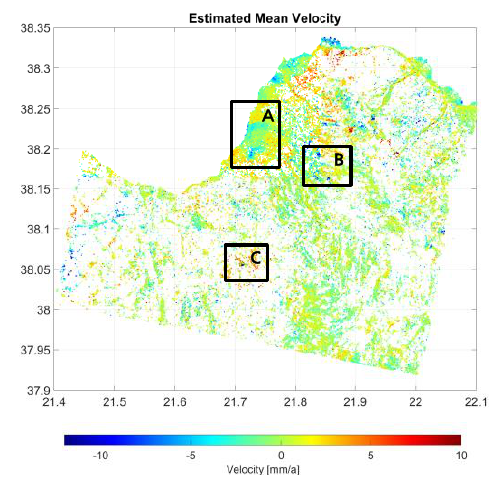
Figure 1 . Estimated mean velocities of the region surrounding Patras, Greece (Jan. 2019 to Jan.